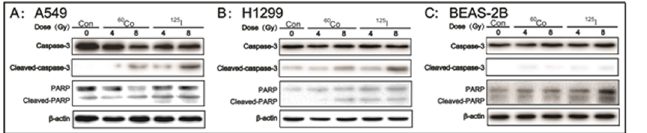
Fig 5. The expression of cleaved-caspase-3 and cleaved-PARP proteins in A549, H1299 and BEAS-2B cells after exposure to 125 I seeds CLDR radiation and 60 Co γ -ray HDR radiation of 4 and 8 Gy. One representative result of three independent experiments with identical results is